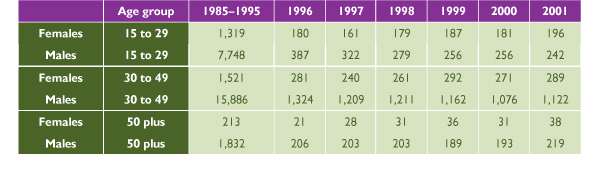
Number of Positive HIV Test Reports among Adult Females and Males(≥ 15 Years), by Age Group and Year of Test, 1985–2001 Source: Data from HIV and AIDS in Canada, Surveillance Report to December 31, 2001